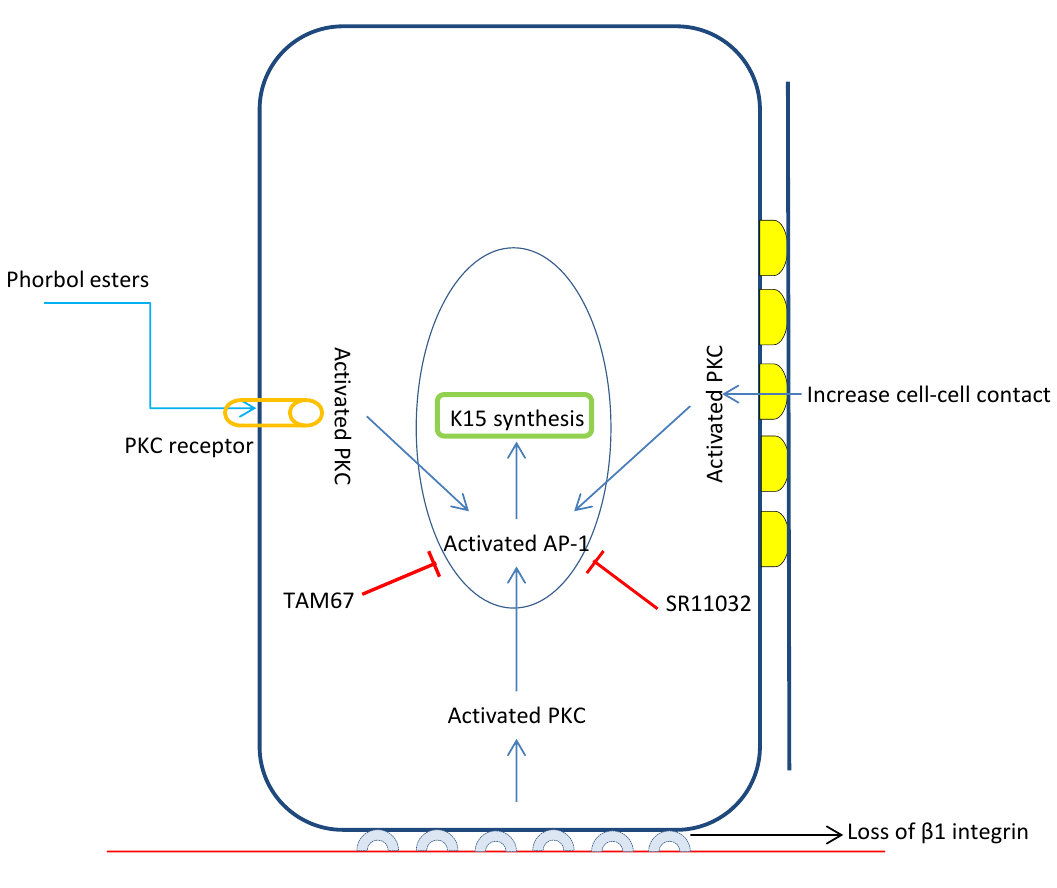
Figure 1. Schematic representation of the molecular signalling responsible for the differentiation-specific induction of Keratin 15 (K15) expression. Based on our previously published data we propose that K15, although normally a basal-specific keratin, can be induced in differentiating keratinocytes via Protein Kinase-C (PKC)/AP-1 pathway. Differentiation-specific signals, such as loss of cell-surface β1 integrin receptors, increased cell-cell interactions or exposure to tumour-promoter phorbol esters, activate the endogenous PKC signalling, which results in activation of downstream transcription factors AP-1, which in turn induce K15 gene transcription. Blocking the activation of AP-1 by specific inhibitor, SR11302, or by dominant negative form of c-Jun, TAM67, inhibits the transcriptional induction of K15